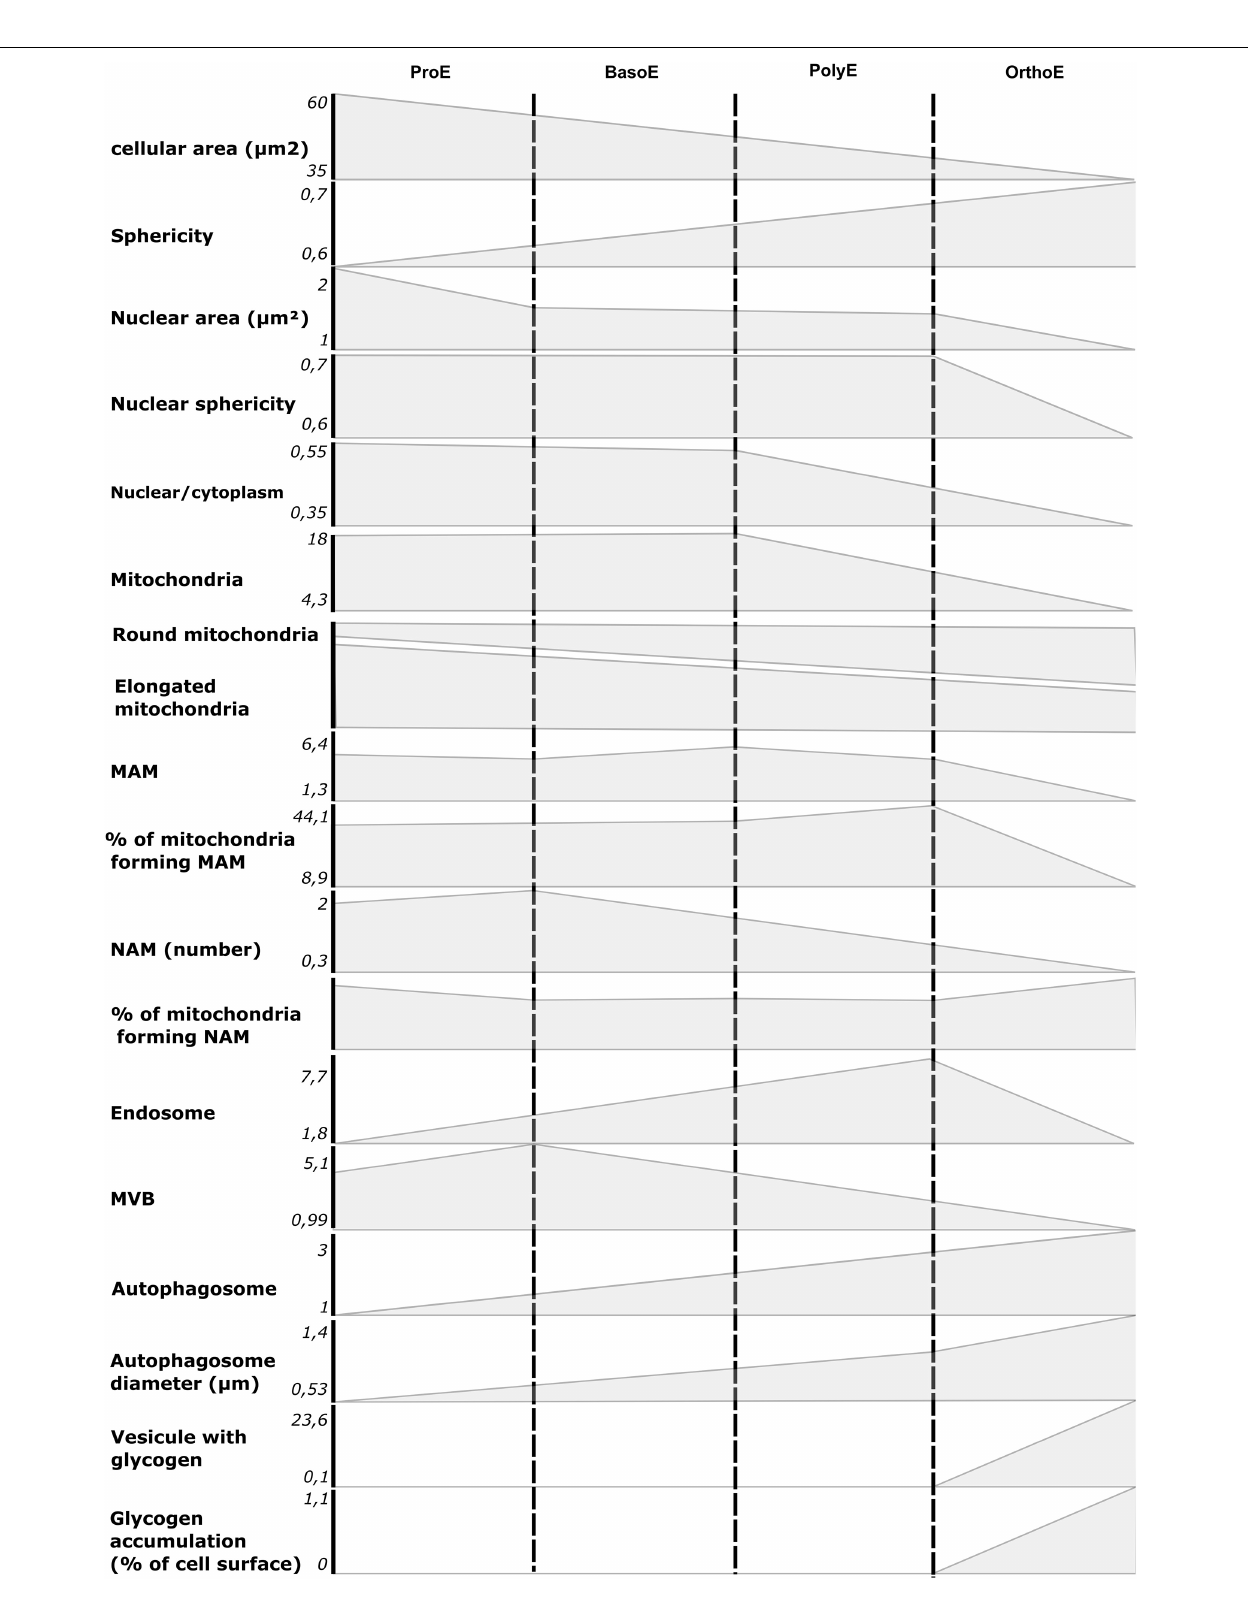
FIGURE 7 | Summary of morphological and ultrastructural quantifications from our analysis. The mean value for ProE to OrthoE stages was reported on ordinate for each quantified item presented in this article.